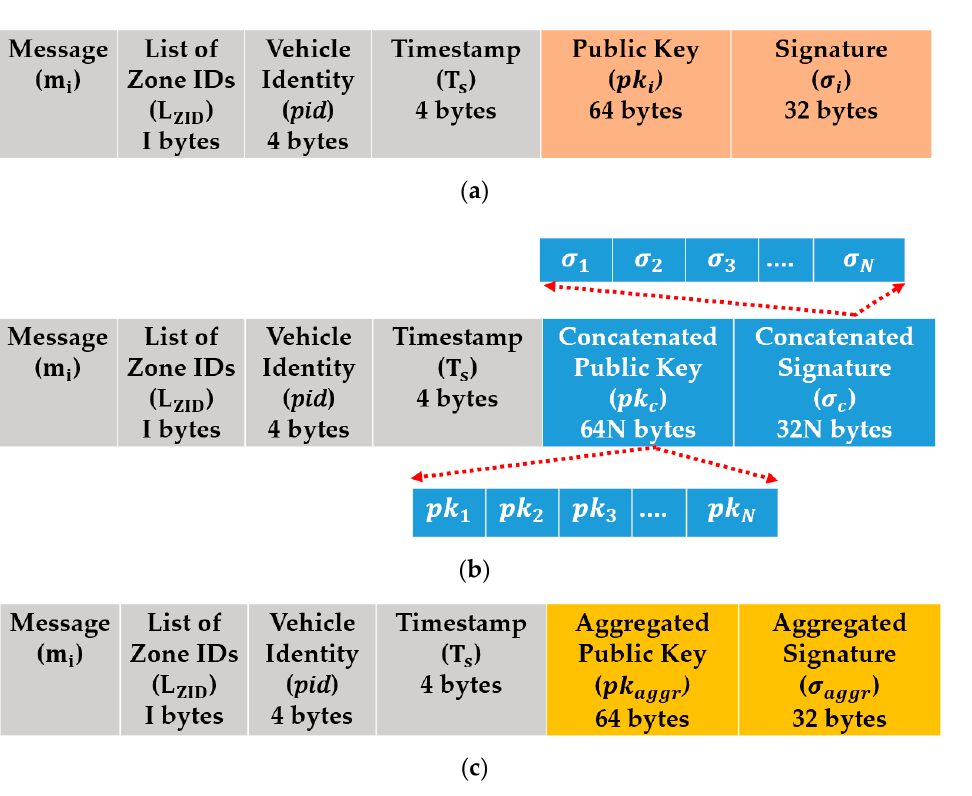
Figure 10. The proposed protocol message structure. ( a ) TCA method, ( b ) SCA method, and ( c ) RCA method. Where m i represents the message payload, pid i represents the pseudo-identity of v i , and L ZID represents a list of zone IDs. T s represents the time stamp, pk i represents the public key of v i , and σ i represents the signature over the message. In our implementation, a signature σ i ∈ G 1 and the public key pk i is ∈ G 2 . The total communication overhead of one message is | L ZID | + | pid | + | T s | + | pk | + | σ | = 4 + 4 + 1 + 64 + 32 = 105 bytes.